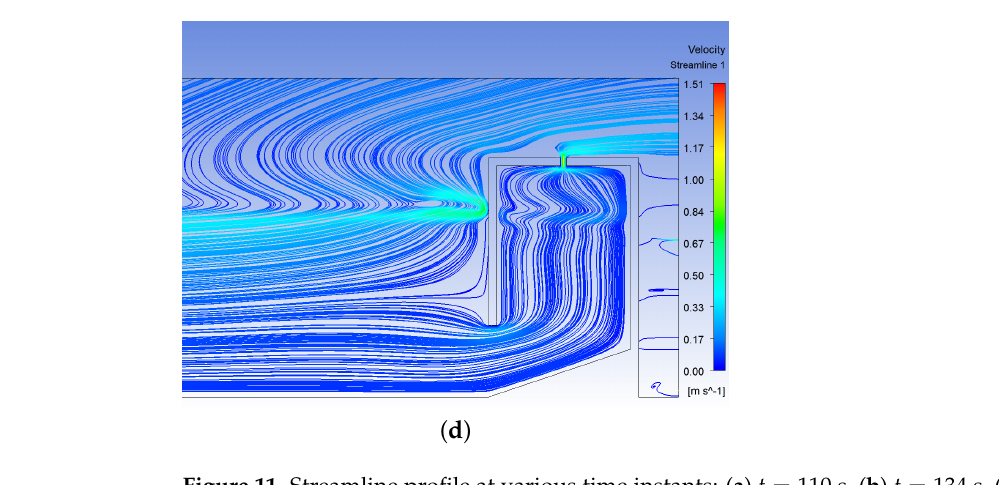
Figure 11. Streamline profile at various time instants: ( a ) t = 110 s, ( b ) t = 134 s, ( c ) t = 165 s, and ( d ) t = 180 s, with H s = 1.88 m and ω p = 0.993 Hz.